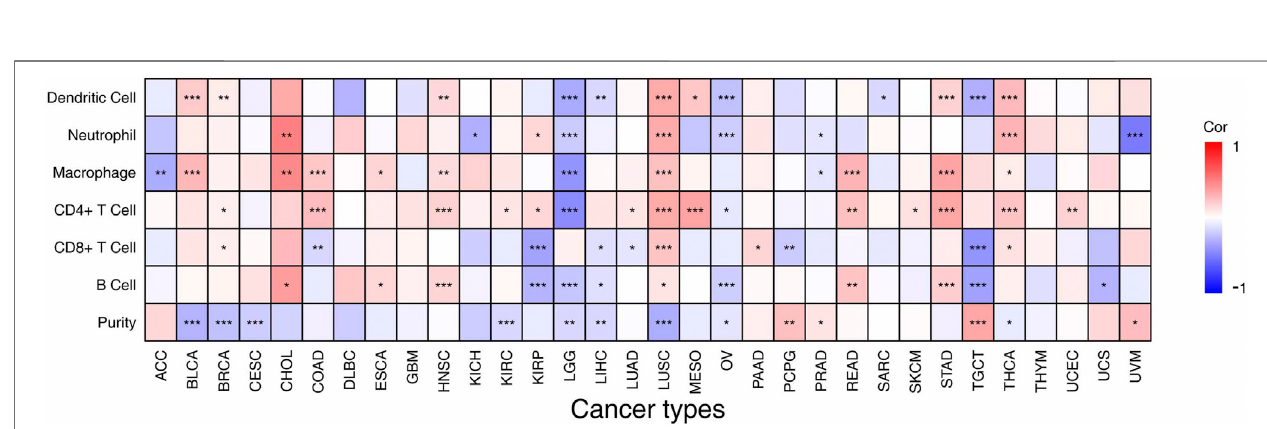
molecules ( Figure 7C , details are shown in Supplementary Figure S6 ) in 33 tumors from the TISIDB database. VSTM2L expression was positively associated with that of immune checkpoint markers as well as immunostimulators in BLCA, BRCA, ESCA, HNSC, LUSC, STAD, and THCA, whereas a negative association was observed in KIRP and LGG. In particular, there was a complex relationship between VSTM2L